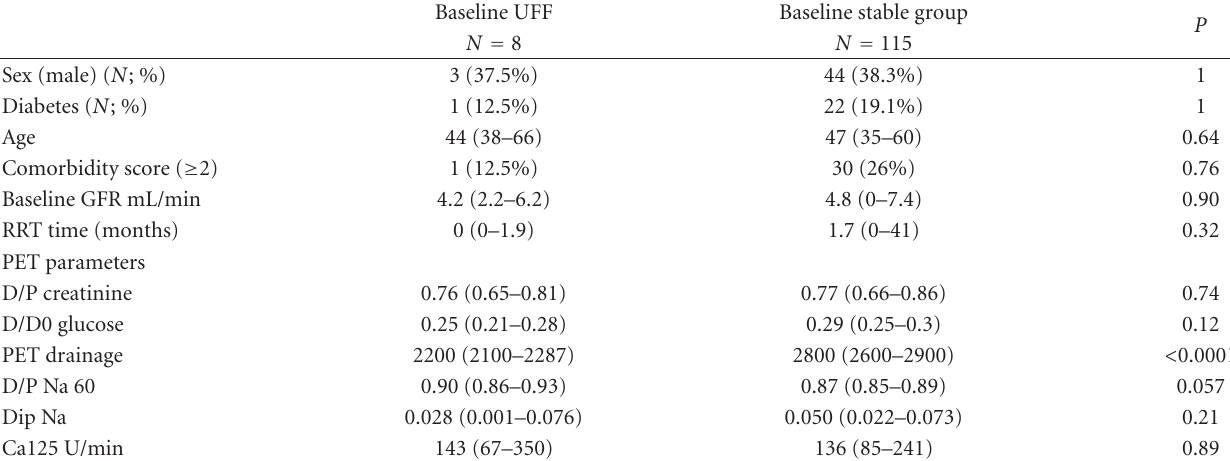
Table 1: Comparison between inherent (baseline) UFF group and baseline-stable patients (categorical data as number (percentage) compared by Fisher’s exact test; continuous data presented as median (25%–75% interquartile range), compared by Mann Whitney U